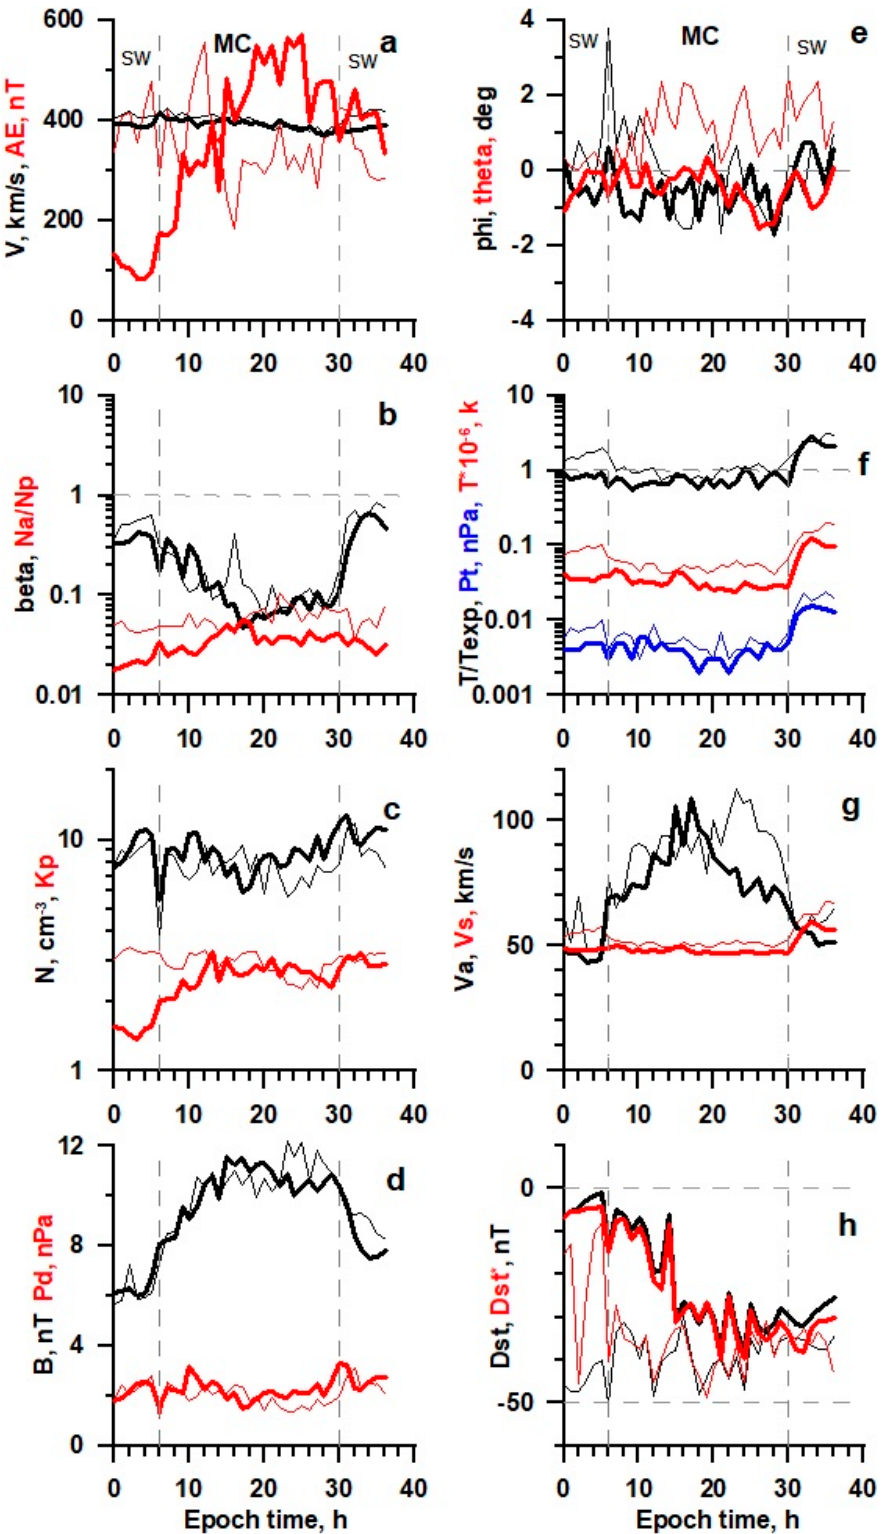
Figure 6. The temporal profile of solar wind and IMF parameters (see legend in the text) for MC obtained by the double superposed epoch analysis for 13 events in 21–22 SCs (thin lines) and 13 events in 23–24 SCs (thick lines).